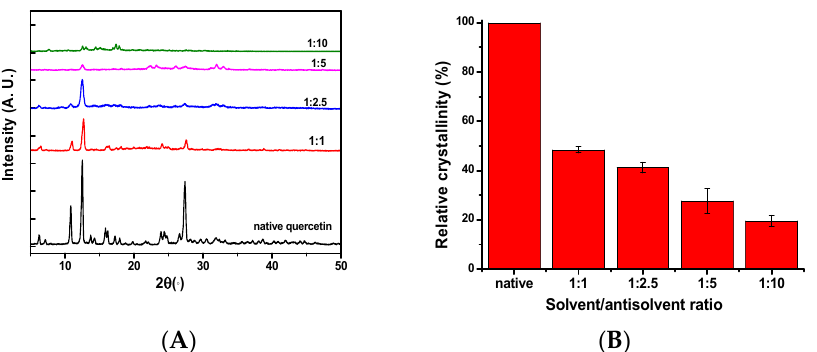
Figure 4. XRD ( A ) and relative crystallinity (%) ( B ) of native quercetin and quercetin particles formed by antisolvent precipitation with various antisolvent ratios (1:1, 1:2.5, 1:5, 1:10).